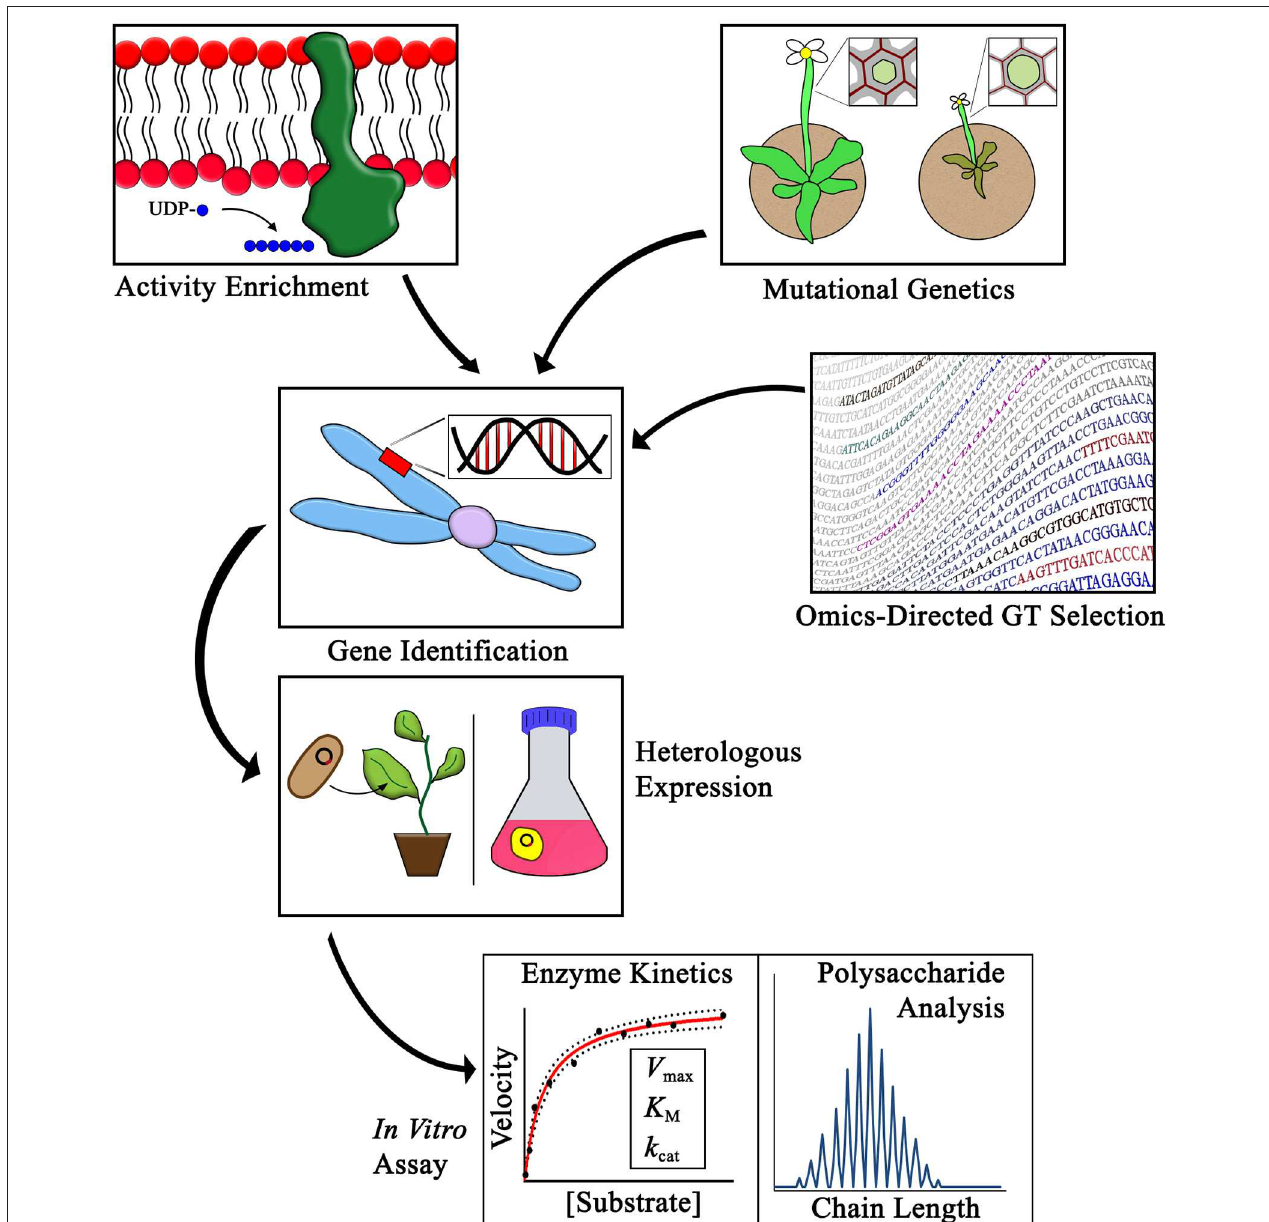
FIGURE 1 | Methods for identifying CWGTs for in vitro activity verification. The activities of plant cell wall glycosyltransferases have been identified using three main strategies as outlined in this review: activity enrichment, mutational genetics, and omics-directed GT selection. Heterologous expression and in vitro assays are critical steps in the process of verifying the synthesis of specific cell wall linkages associated with different families of CWGTs. Purification of enzymes following heterologous expressional enables advanced studies of GT mechanism, including enzyme kinetic, and polysaccharide chain length analyses.